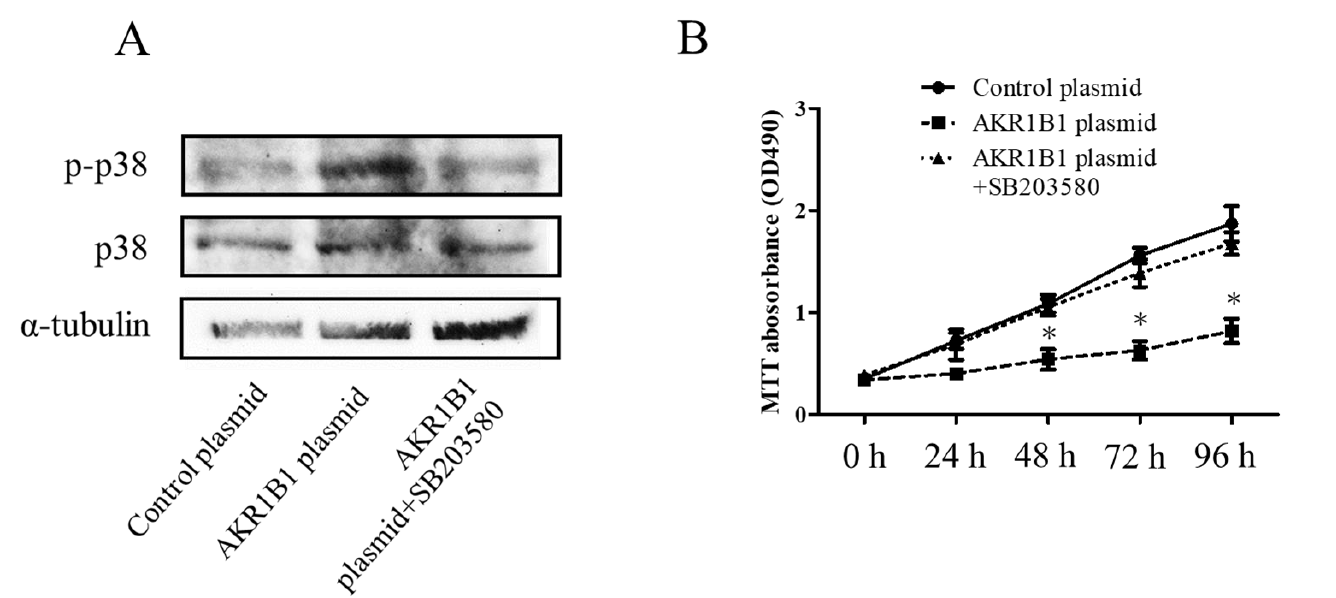
Figure 4. AKR1B1 exerted an antitumor effect by regulating the p38 MAPK signaling pathway. ( A ) Representative Western blot results reveal increased p38 MAPK phosphorylation in T98G cells with overexpressed AKR1B1 ( n = 3). ( B ) Ten micromolar of p38 MAPK inhibitor (SB203580) reversed the antiproliferative effect of AKR1B1 on T98Gcells. T98G cells were transfected with the control plasmid, the AKR1B1 plasmid, and the AKR1B1 plasmid with SB203580. Cell viability was measured by the MTT assay at 0, 24, 48, 72, and 96 h after transfection ( n = 3). Data are presented as mean ± SEM from three independent experiments; * p < 0.05.